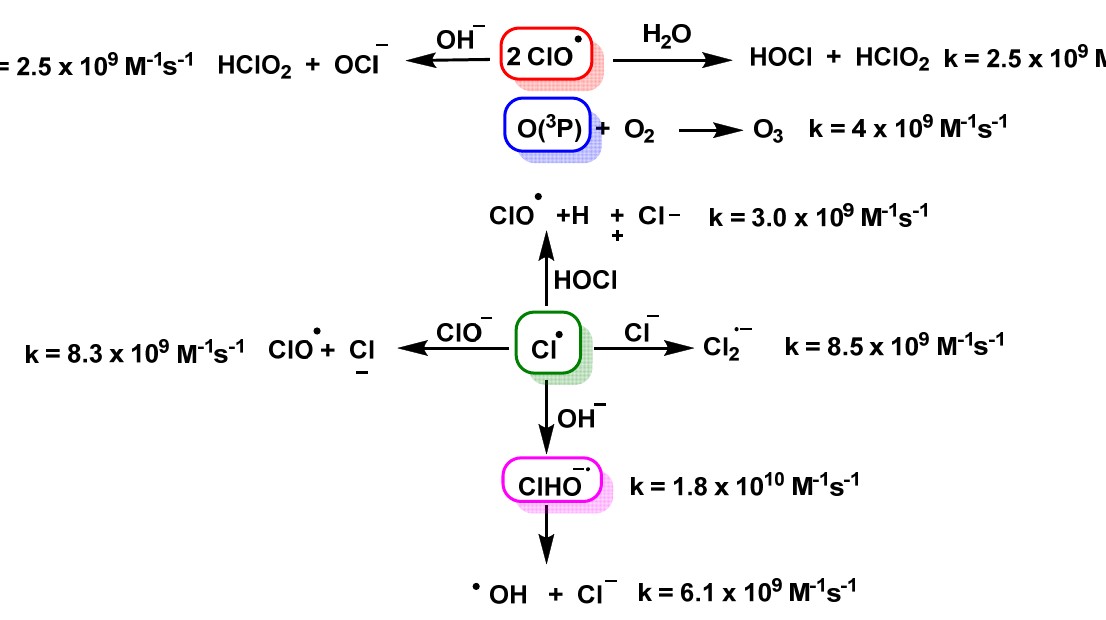
Figure 21. The photochemistry and radical chemistry of photolysis of ClO 2 by UVC light. The above species can undergo chain reactions to generate secondary reactive species [54,55], Figure 22.